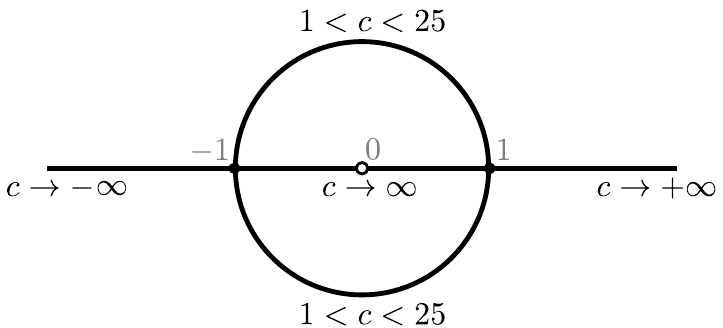
Figure 8 . The complex b 2 -plane with the value of the central charge c = 13 + 6( b 2 + b (cid:0) 2 ) shown. It is real on the real line and on the unit circle. Teichm(cid:127)uller TQFT is de(cid:12)ned for b 2 > 0, or c > 25. On the unit circle, the usual real integration cycle makes sense for complex Chern-Simons theories with coupling constants (5.35) or